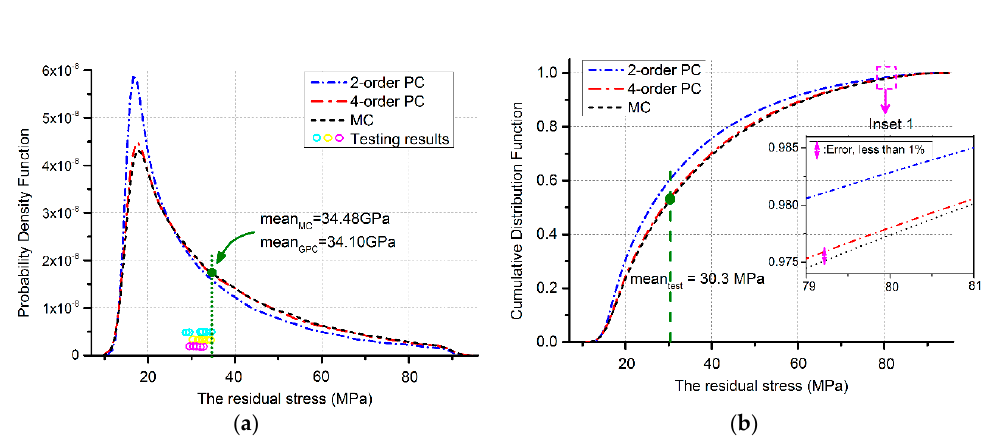
Figure 6. Statistical features of the residual stress: ( a ) PDF approximated by the GPC and MC method (100,000 runs), along with results calculated from testing of 6 samples at room temperature and atmospheric pressure, where the Cyan, magenta and yellow circles correspond to the beam structures with length of 250 μm , 200 μm and 150 μm , respectively; ( b ) CDF approximated by the GPC and MC method, with inset 1 for precision explanations and the marked mean value of testing. Table 2. Mean location of the residual stress and its standard deviation by GPC and MC.